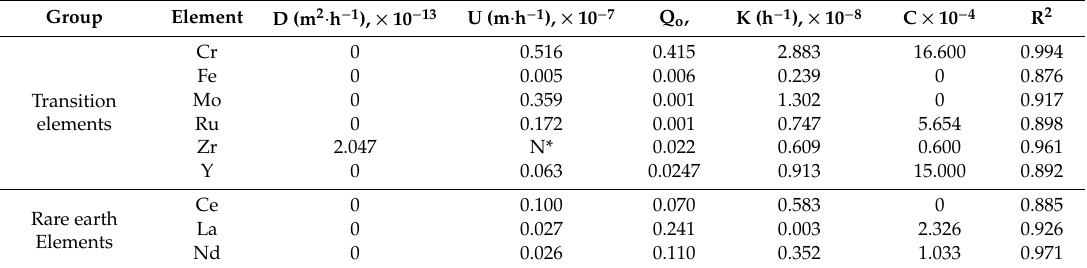
Figure 9. Contribution of different leaching processes to the fractional release of transition metals. Table 15. Nonlinear curve fitting parameters of the cumulative leach fraction of transition and rare earth elements: ABS-Waste (17).